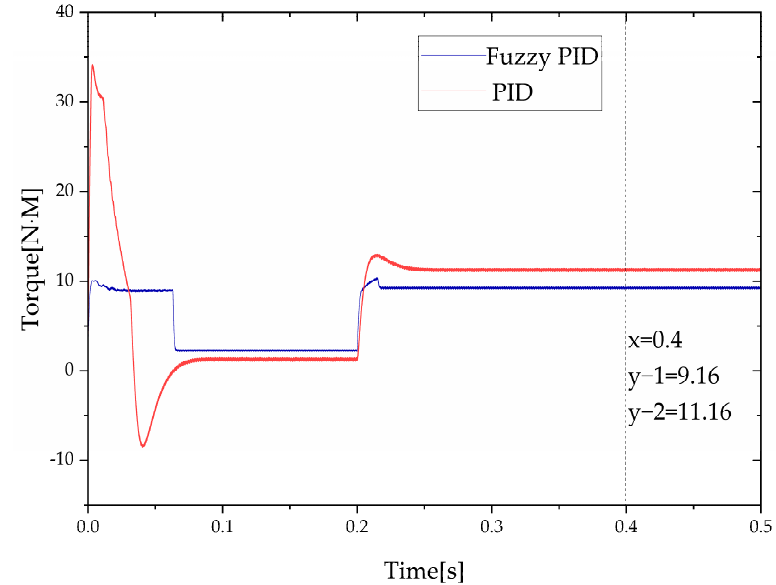
Figure 18. PMSM torque curve.